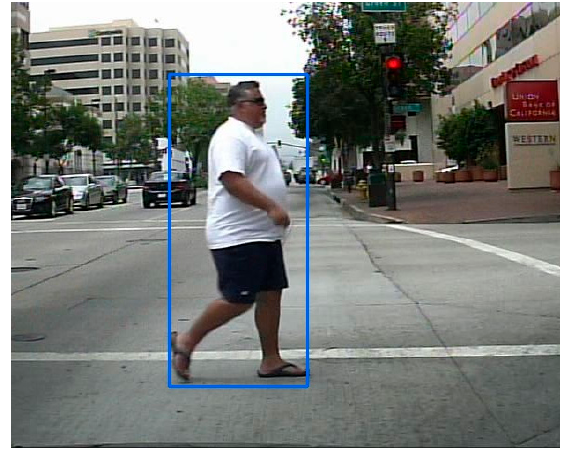
Figure 4. Valid information (center of the bounding box) and background information (edge of the bounding box).